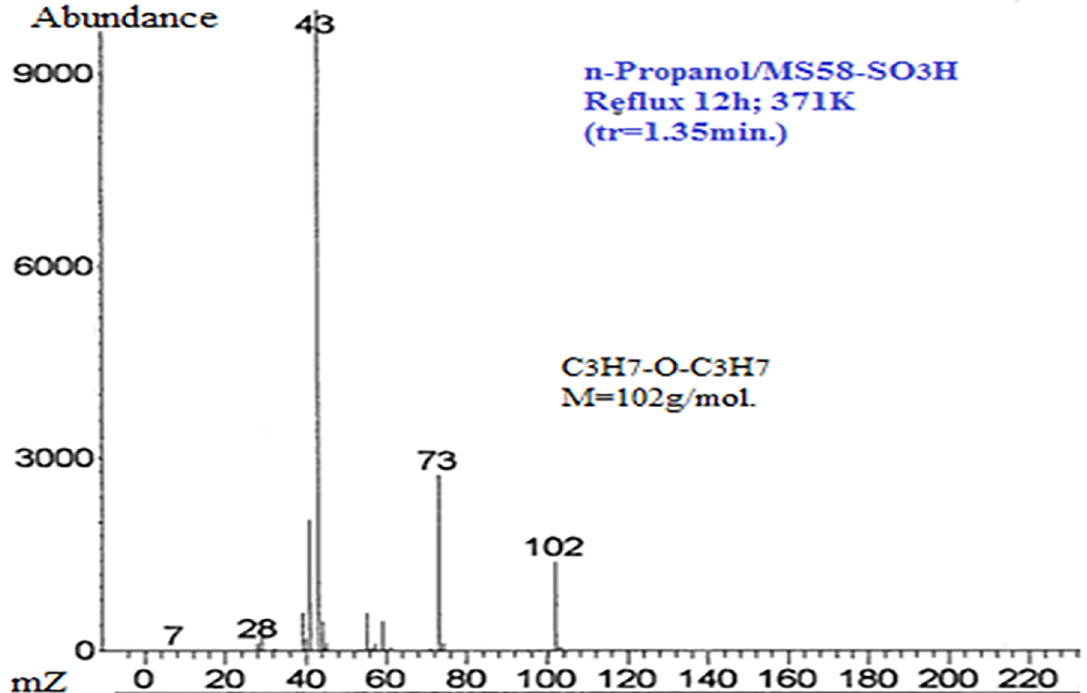
H at retention time tr=1.35min. 3